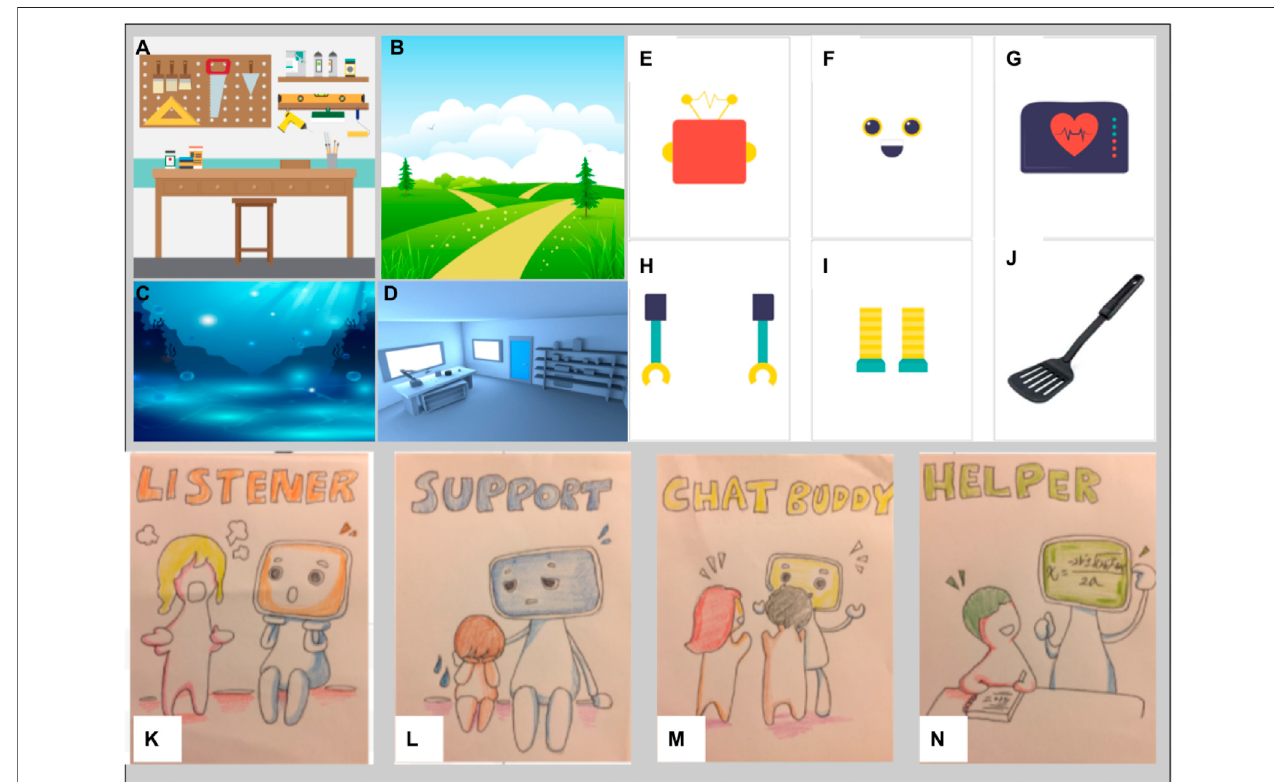
FIGURE 1 | Examples of game cards including design environments (A – D) , modular robot parts (E – J) , and robot attribute cards (K – N) .